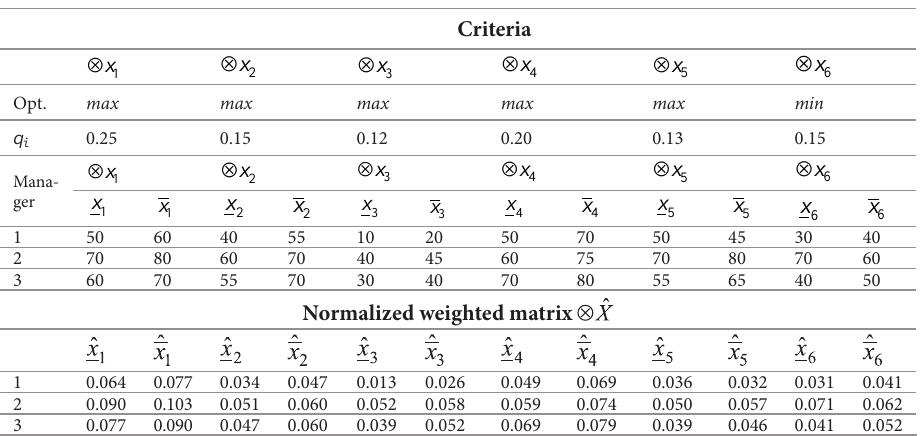
Table 2. Initial decision-making matrix with the criterion values described in intervals ⊗ X and normal- ized weighted matrix Initial decision-making matrix ⊗ X